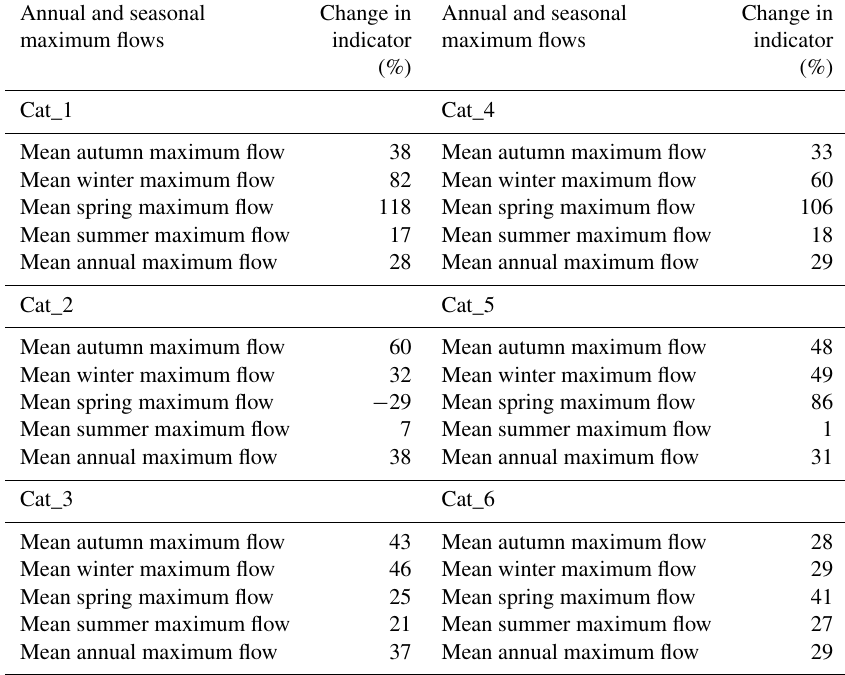
Table 7. Changes in percentage of the mean annual and seasonal maximum flows in the future period compared to the reference period. Annual and seasonal